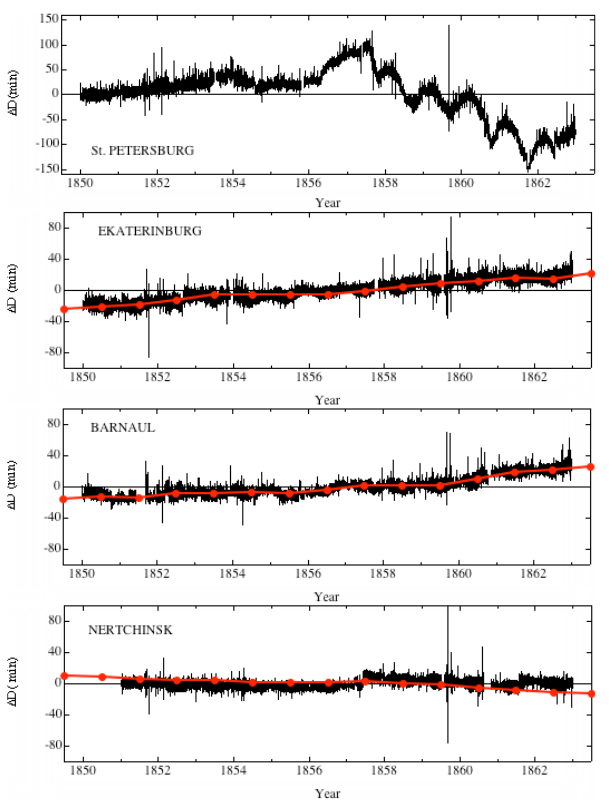
Fig. 4. Hourly values (spot readings) of the magnetic horizontal component ( 1H) in nT 1850–1862. The high spikes here and in Fig. 3 in 1859 (August–September) are signatures of the famous Carrington magnetic